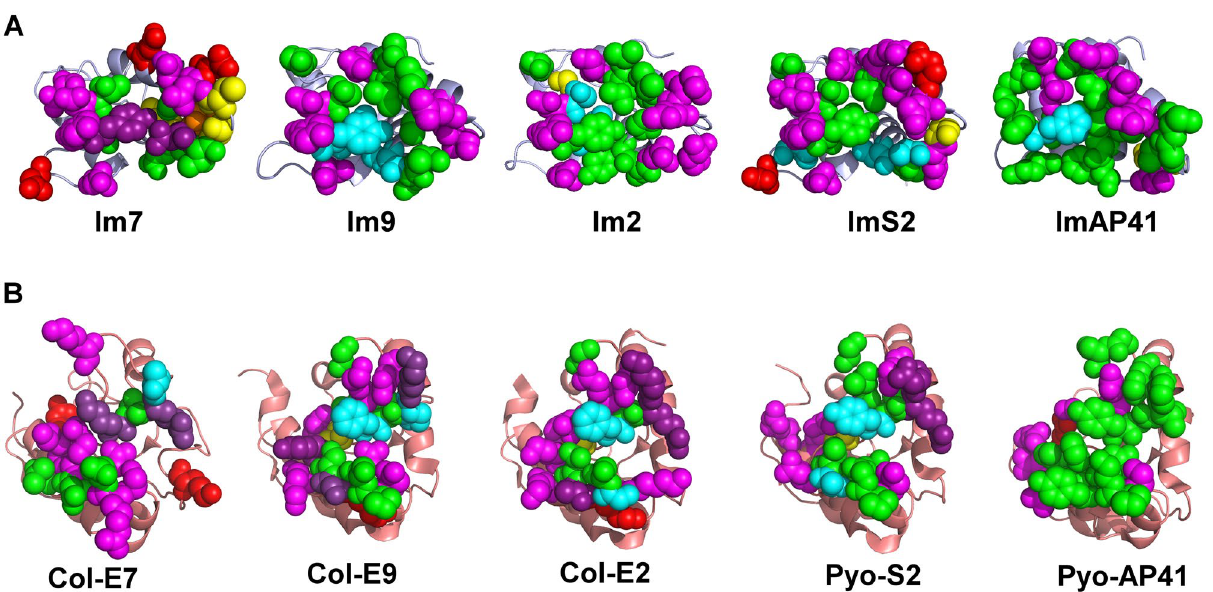
Figure 4. 3D visualization of residues that contribute substantially to interactions between the Im7-like family and the E7-like family. ( A ) Residues in the Im7-like family that substantially contribute to interactions with their cognate colicin/pyocin partners, as in Fig. 3A. ( B ) Residues in the E7-like family that substantially contribute to interactions with their cognate partners, as in Fig. 3B. Substantially contributing residues are shown as spheres and colored as in Fig. 3. Immunity proteins and colicins/pyocins are shown in an “open book” view, where the immunity proteins and colicins/pyocins are rotated ~ 90° about the X-axis in oppositve directions relative to Fig. 1A and shown as ribbons colored light blue and salmon,